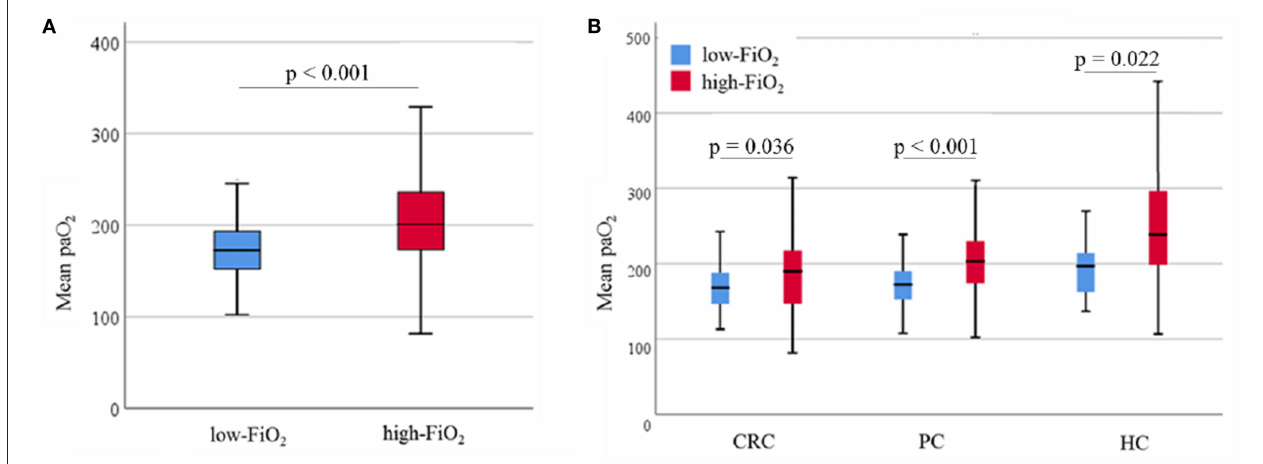
FIGURE 3 | Observed paO 2 . Data are presented as median (interquartile range). Whiskers indicate the minimum and maximum values. P -values were tested using the non-parametric Mann-Whitney U test. (A) Intraoperative mean paO 2 levels of the low-FiO 2 group compared to the high-FiO 2 group. (B) Intraoperative mean paO 2 levels of the low-FiO 2 groups and the high-FiO 2 groups of each entity. paO 2 , Arterial oxygen pressure; CRC, Colorectal cancer; PC, Pancreatic cancer; HC, Hepatic cancer.